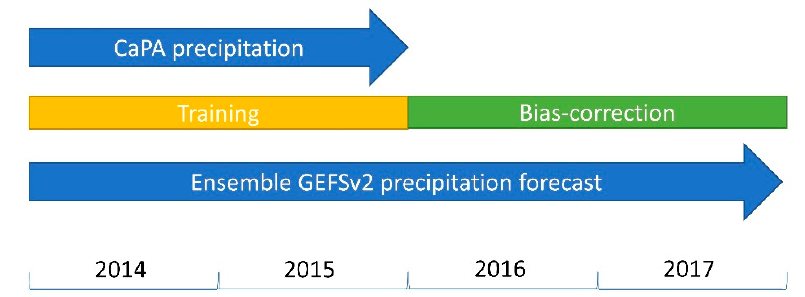
Figure 3. The Bias-correction process using the Empirical Quantile Mapping method.